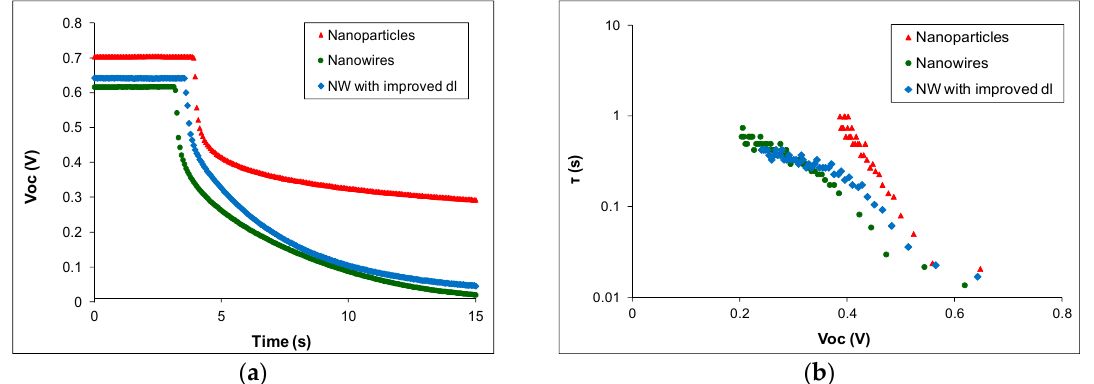
Figure 7. OCVD measurements for ZnO nanoparticle, NW and NW with improved dye loading DSSCs: ( a ) open-circuit voltage decay curves and ( b ) electron lifetime as a function of open-circuit voltage.